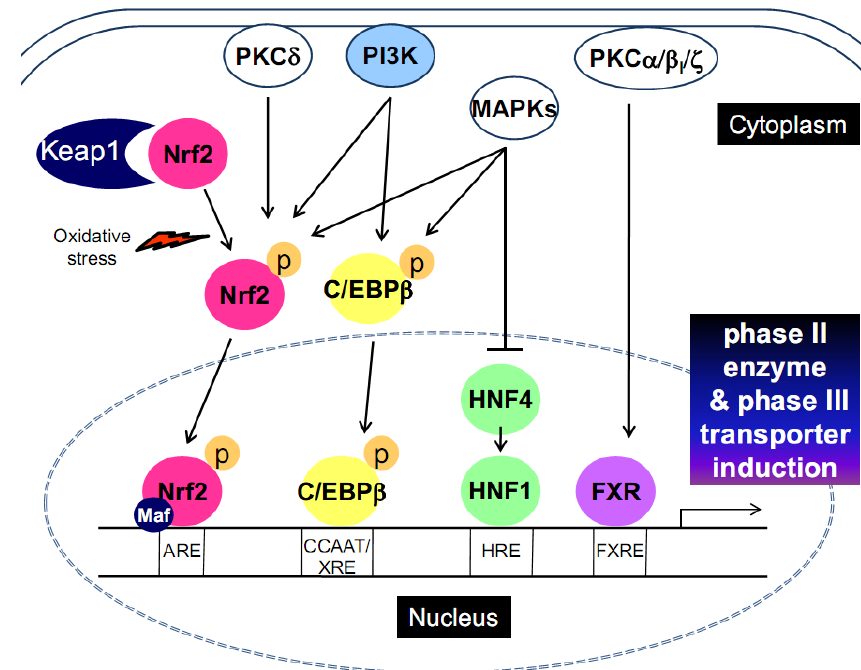
Figure 1. The signaling pathways for transcription factor activation that leads to phase II enzyme and phase III transporter